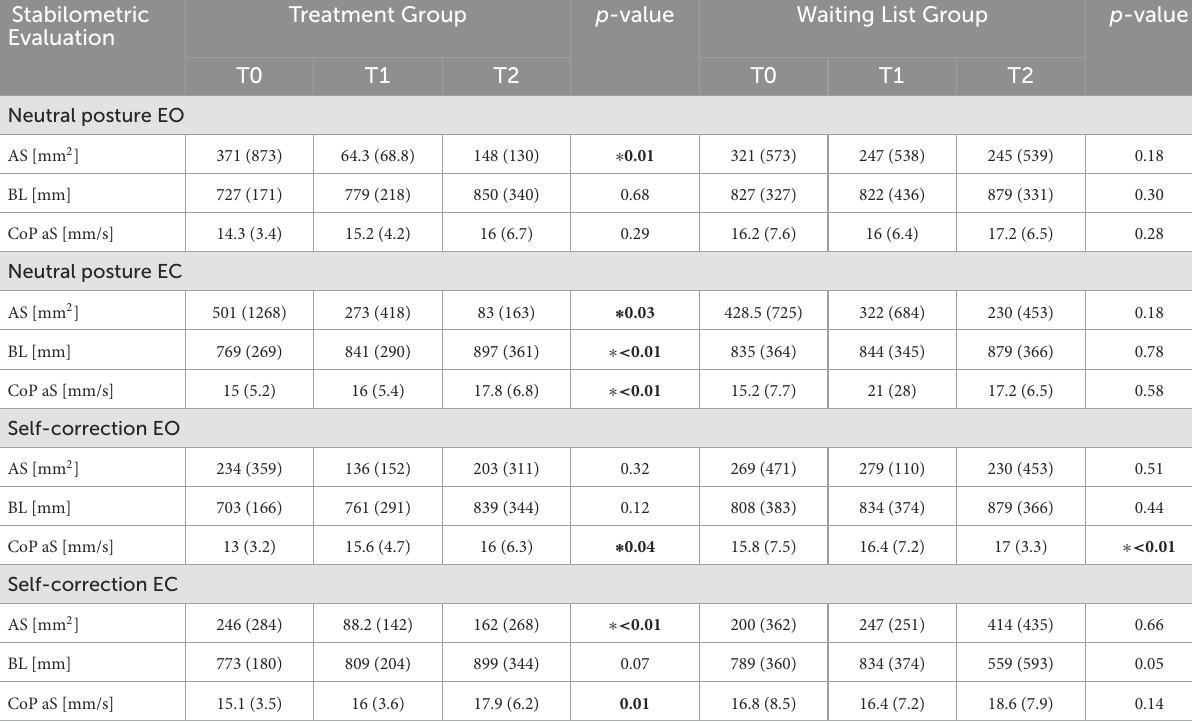
TABLE 7 Mean values, standard deviation and p- values of postural parameters measured during the stabilometric platform test at three timepoints in the two groups. Stabilometric